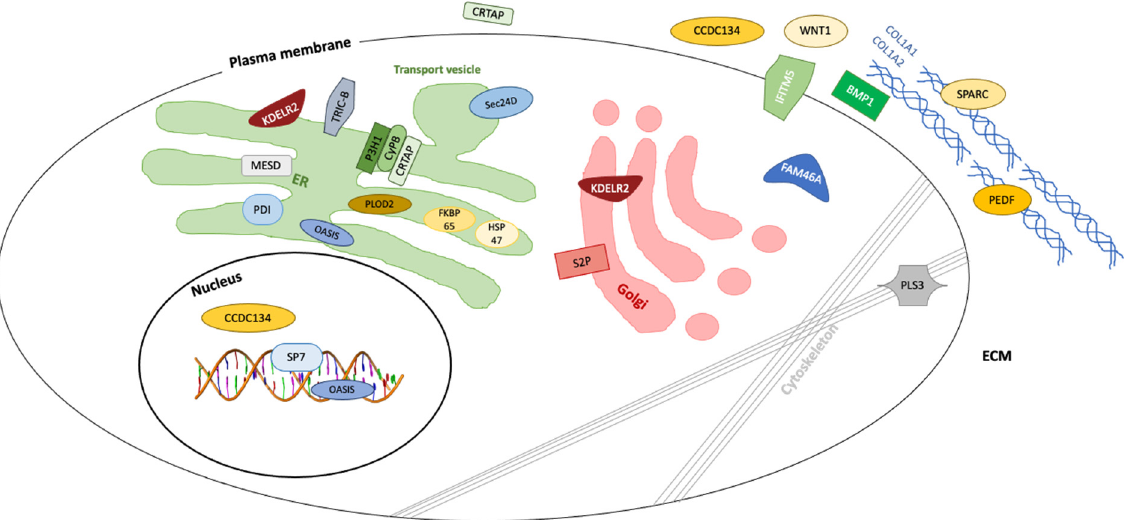
Figure 2. Osteogenesis imperfecta is caused by gene mutations encoding proteins involved in collagen biosynthesis, bone homeostasis and maintenance.